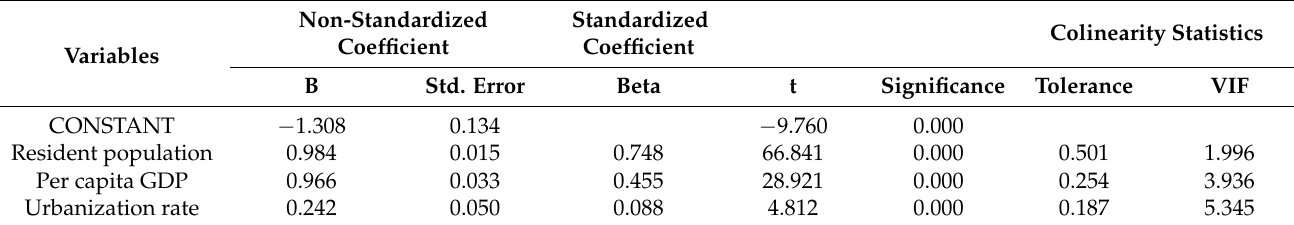
Table 8. Model test results of Chengdu metropolitan